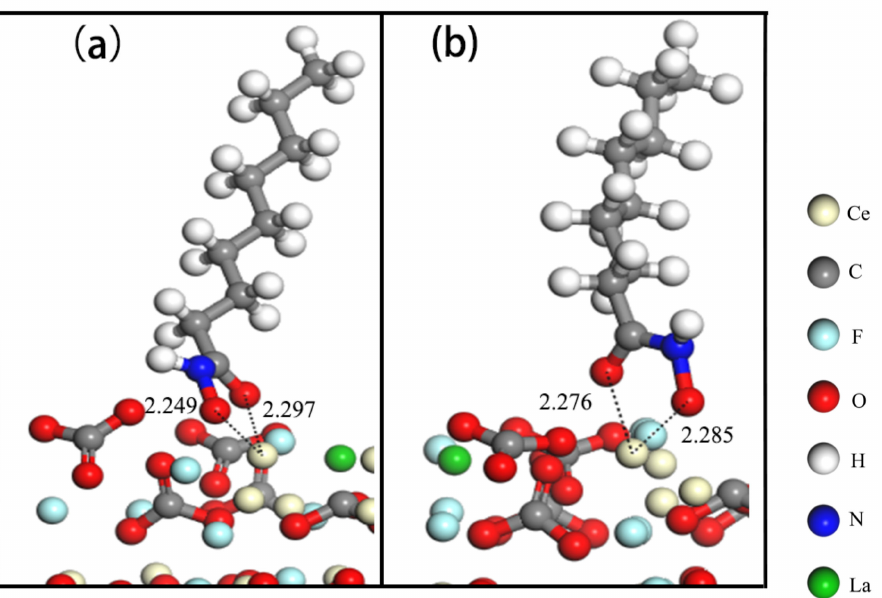
Figure 7. NHA adsorption on the doped bastnaesite (100) surface. La doping at ( a ) position 1 and ( b ) position